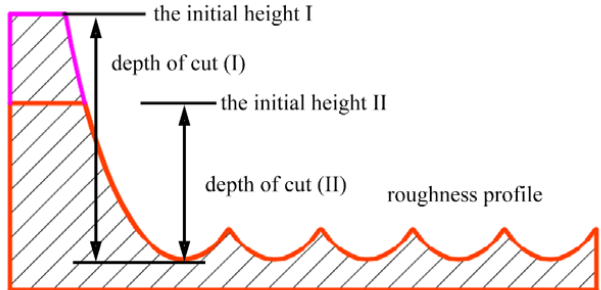
Figure 8. Illustration of the generated cross-sectional profile at di ff erent depths of the cut, where the cross-sectional profile under two conditions are the same when the depth of the cut is smaller than the height of the circular area of the diamond